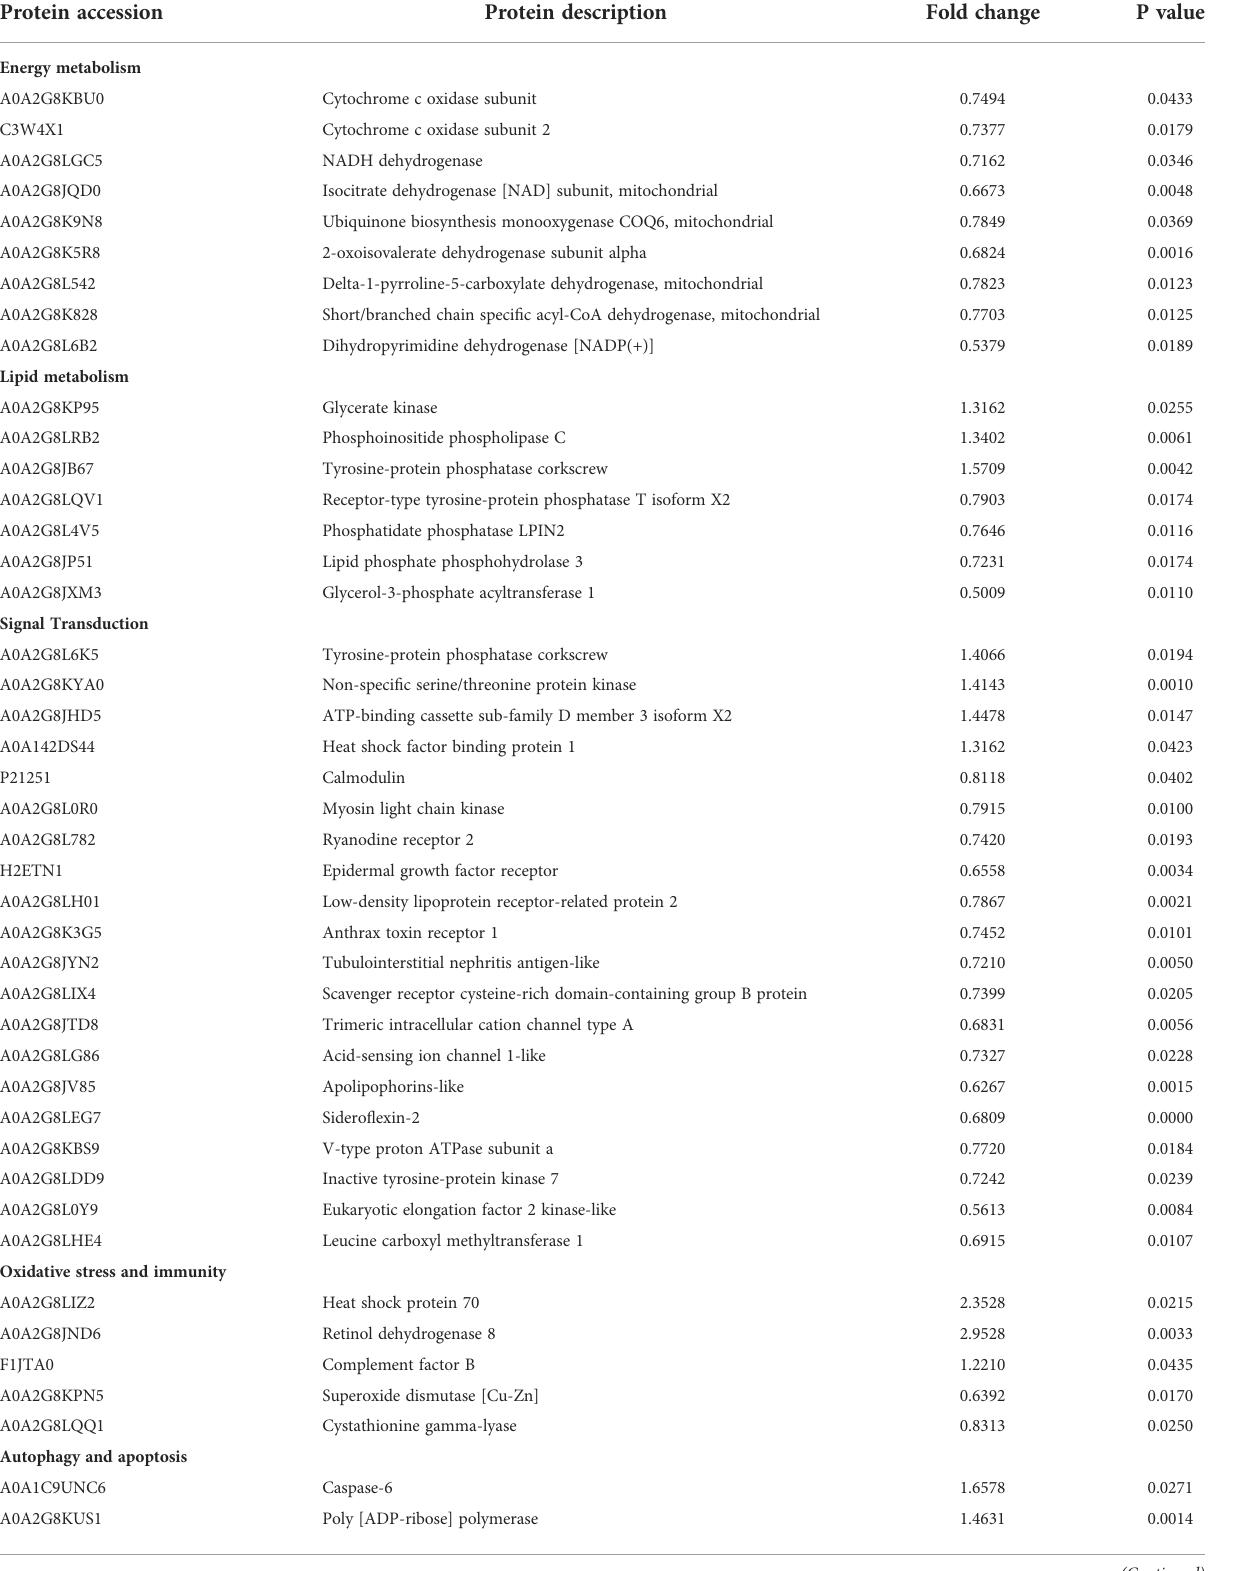
TABLE 1 Details of differentially expressed proteins (DEPs) in A. japonicus in response to SMC treatment. Protein accession Protein